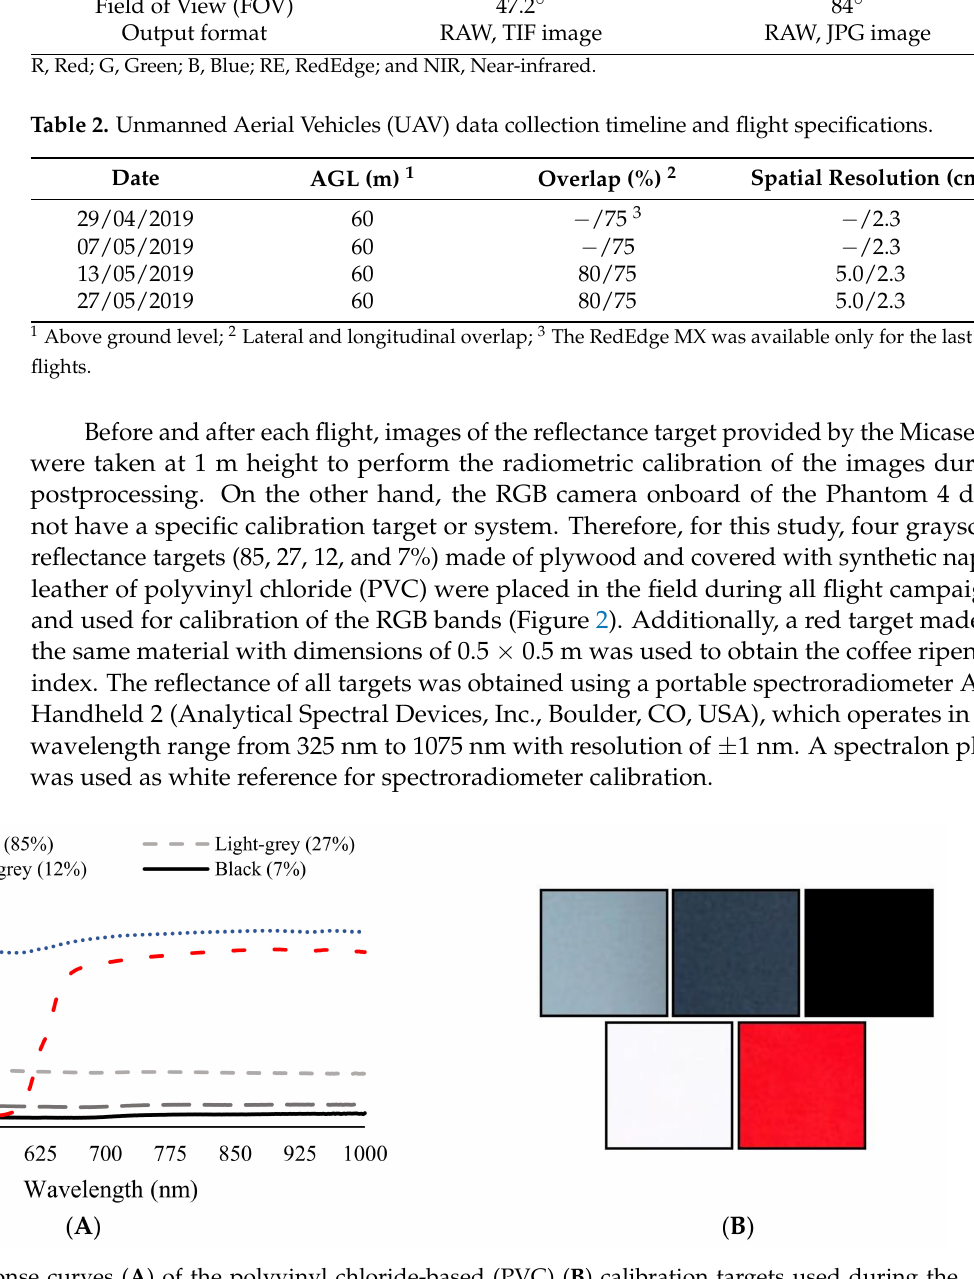
Figure 2. Spectral response curves ( A ) of the polyvinyl chloride-based (PVC) ( B ) calibration targets used during the flight